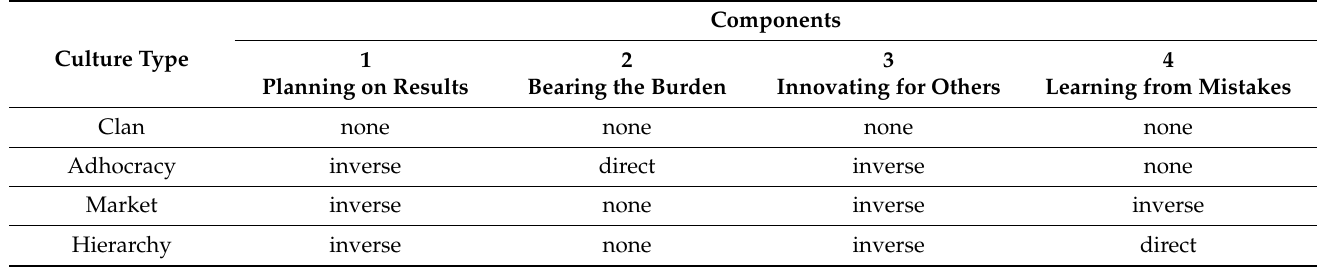
Table 5. Summary of direction of relationships between culture types and